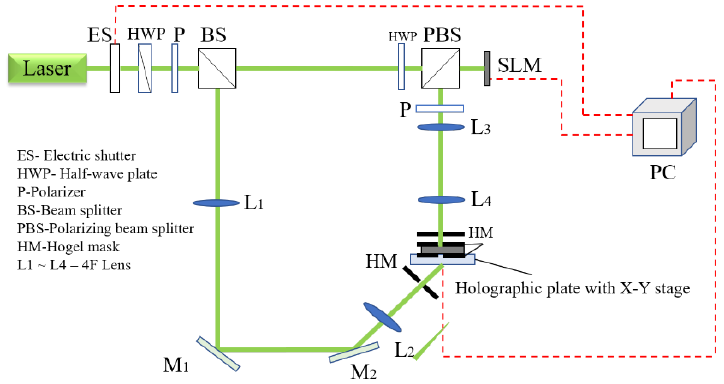
Figure 9. Optical setup for holographic stereogram printing.